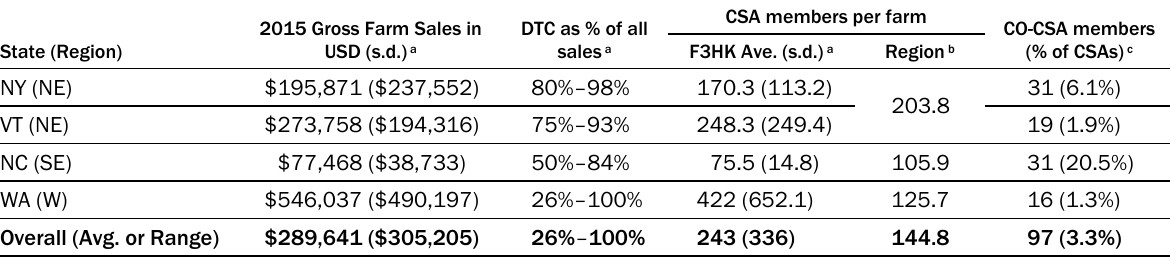
Table 1. Characteristics of Farm Fresh Foods for Healthy Kids (F3HK) Farm Operations, 2016, Averaged by